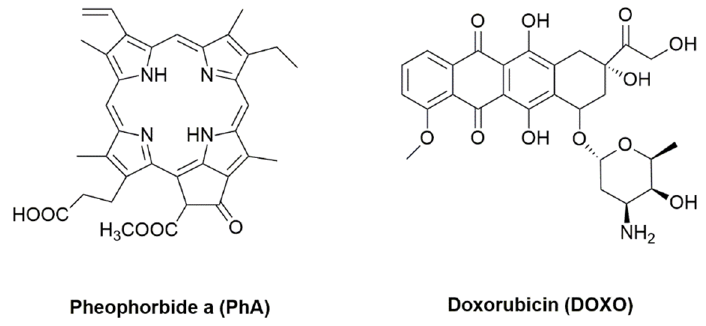
Figure 1. Structures of the active compounds studied in this work.